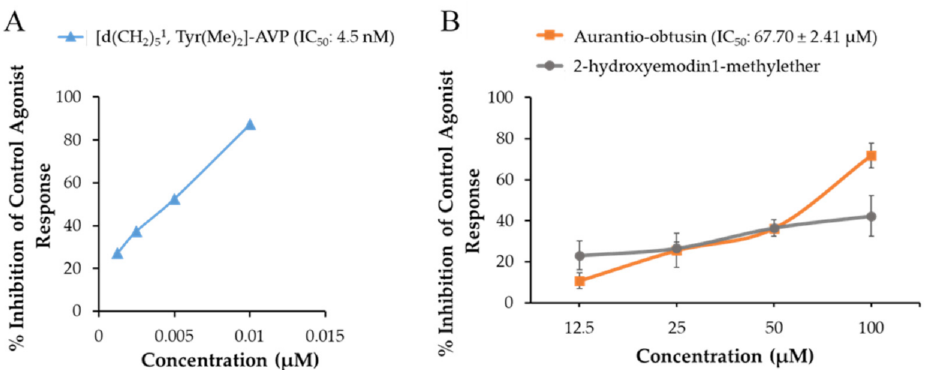
Figure 2. Concentration-dependent vasopressin V 1A R antagonist effect of ( A ) reference antagonist (d(CH 2 )5 1 ,Tyr(Me) 2 ]-vasopressin (AVP)) and ( B ) active compounds from Cassia seeds (aurantio- obtusin and 2-hydroxyemodin 1-methylether). Reference drugs and test samples were tested at the indicated concentration for antagonist effect by determining the percentage inhibition of con-